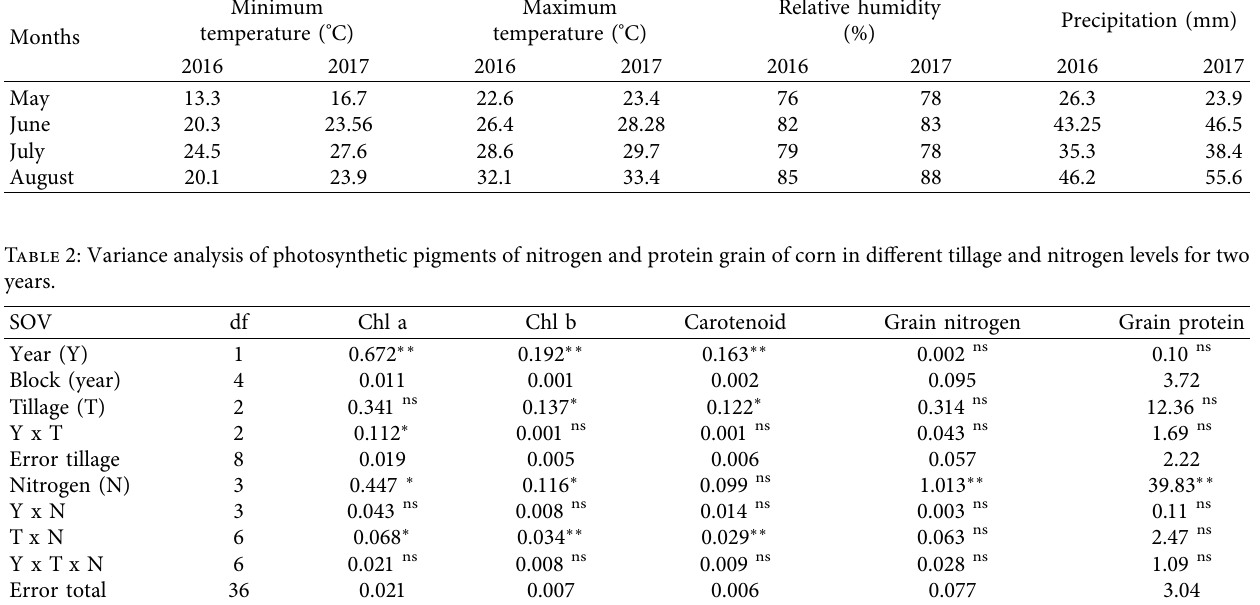
Table 1: Meteorological parameters for the field site during the experiment (Mazandaran Province Meteorological Office). Months